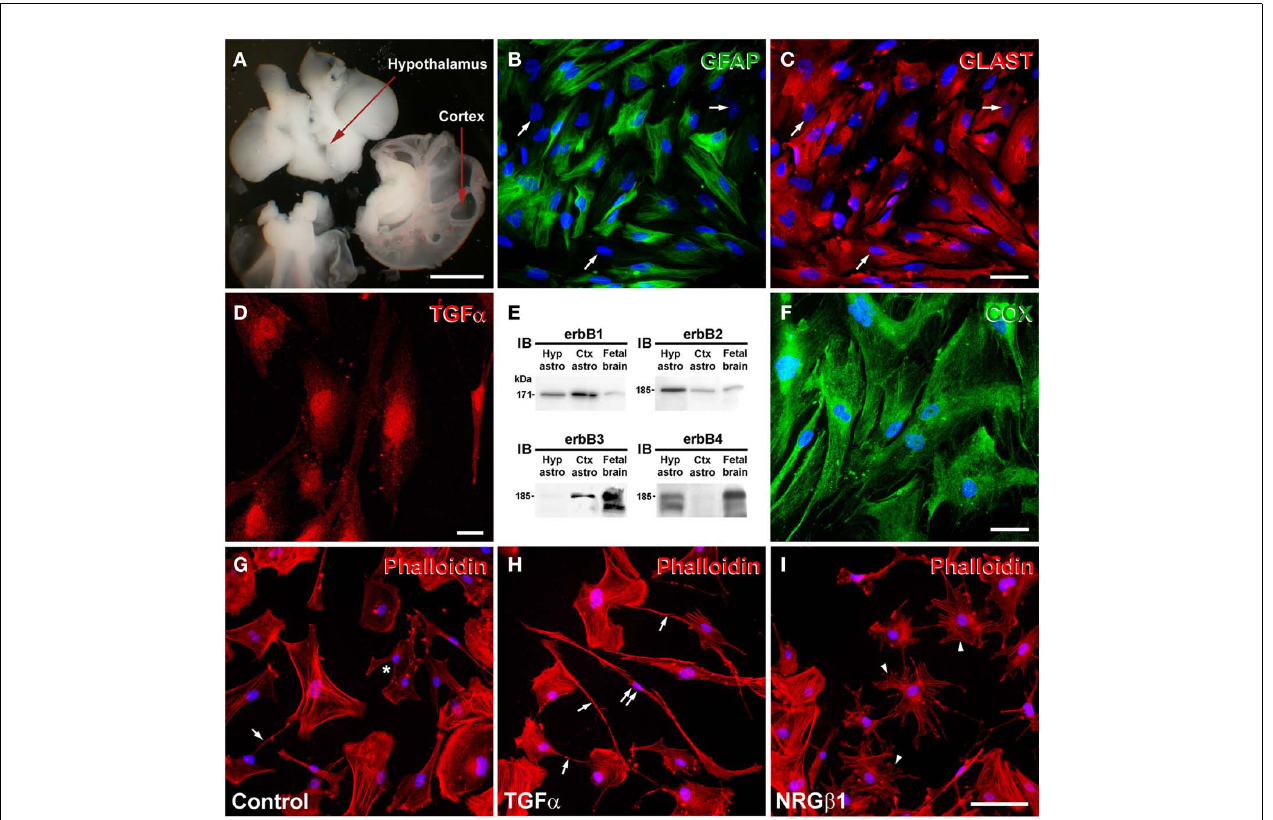
(F) Human hypothalamic astrocytes in culture are immunopositive for COX (green). (G–I) EGF ligands induce profound morphological rearrangements of human hypothalamic astrocytes in vitro . Cell morphology was examined by visualization of the actin cytoskeleton using Alexa Fluor 568-conjugated phalloidin (red). Hypothalamic astrocytes exhibit heterogeneous shapes under control conditions, i.e., polygonal cells, cells with short and thick extensions (asterisk) or long and thin processes (arrow) (G) .TGF α (50ng/mL for 3days) stimulates the extension of long and thin processes (arrows) and the apparition of bipolar cells (double arrows) (H) while treatment with neuregulin-1 NRG β 1 (50ng/mL for 3days) increases the number of multipolar cells with thick processes (arrowheads) (I) . Nuclei are counter-stained with Hoechst [ (B,C,F–I) , blue]. Scale bars = 3mm (A)